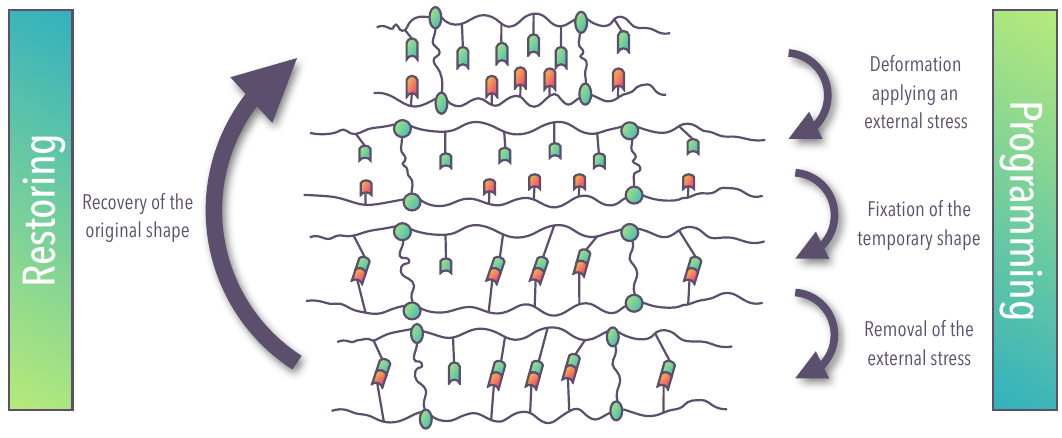
Figure 3. Schematic representation of the molecular mechanism of shape-memory material (SMM) (modified from Iqbal et al. [21]).